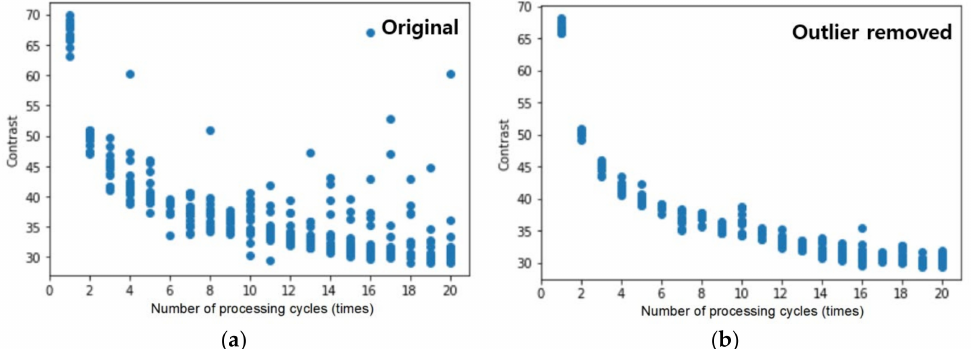
Figure 8. ( a ) Scatter plot of the intensity data by processing number, including outliers and missing values; ( b ) scatter plot of the intensity data by processing number, with outliers and missing values eliminated using the standard deviation